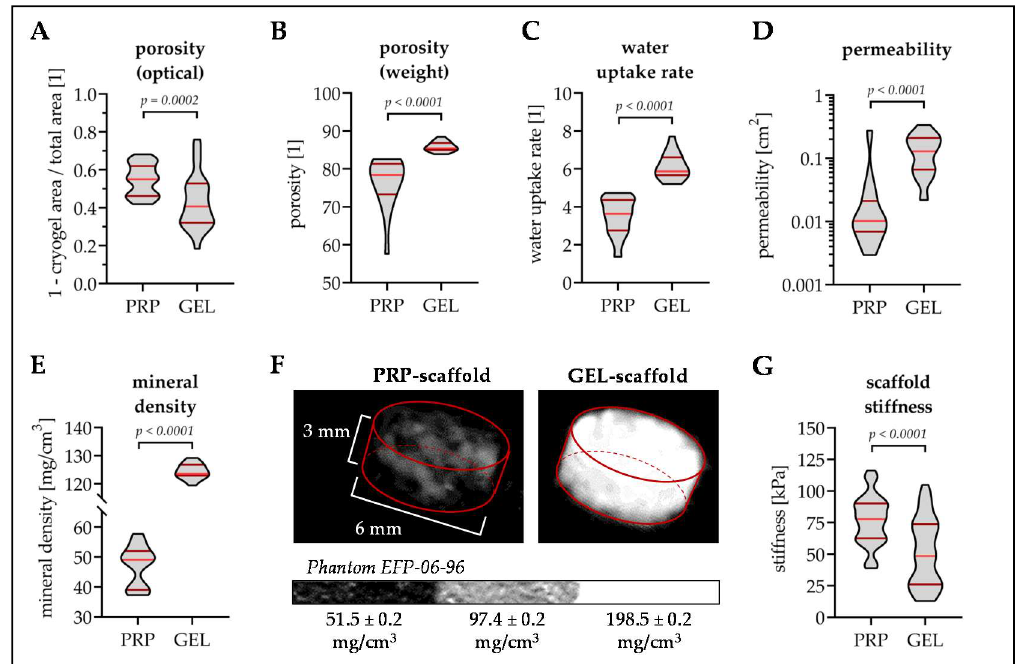
Figure 3. Physical characteristics of the PRP and GEL scaffolds. ( A ) Porosity of the two scaffolds was optically determined (fluorescent images with 40 × magnification) using the plugin “BoneJ” of the ImageJ software (“volume fraction”). In addition, ( B ) the porosity and ( C ) the water uptake rate was determined via the dry and wet weight of the scaffolds. ( D ) The permeability of the two scaffolds was determined based on the law of Darcy. ( E ) The mineral content of the two scaffolds was determined by quantitative computed tomography (CT). ( F ) Showing representative 3D reconstructions of the CT scans. ( G ) Scaffold stiffness was determined by cyclic compressions using a material testing machine. For each scaffold, at least, 15 individual measurements were taken for analysis. Non-parametric Mann–Whitney U-test was used for data comparison.